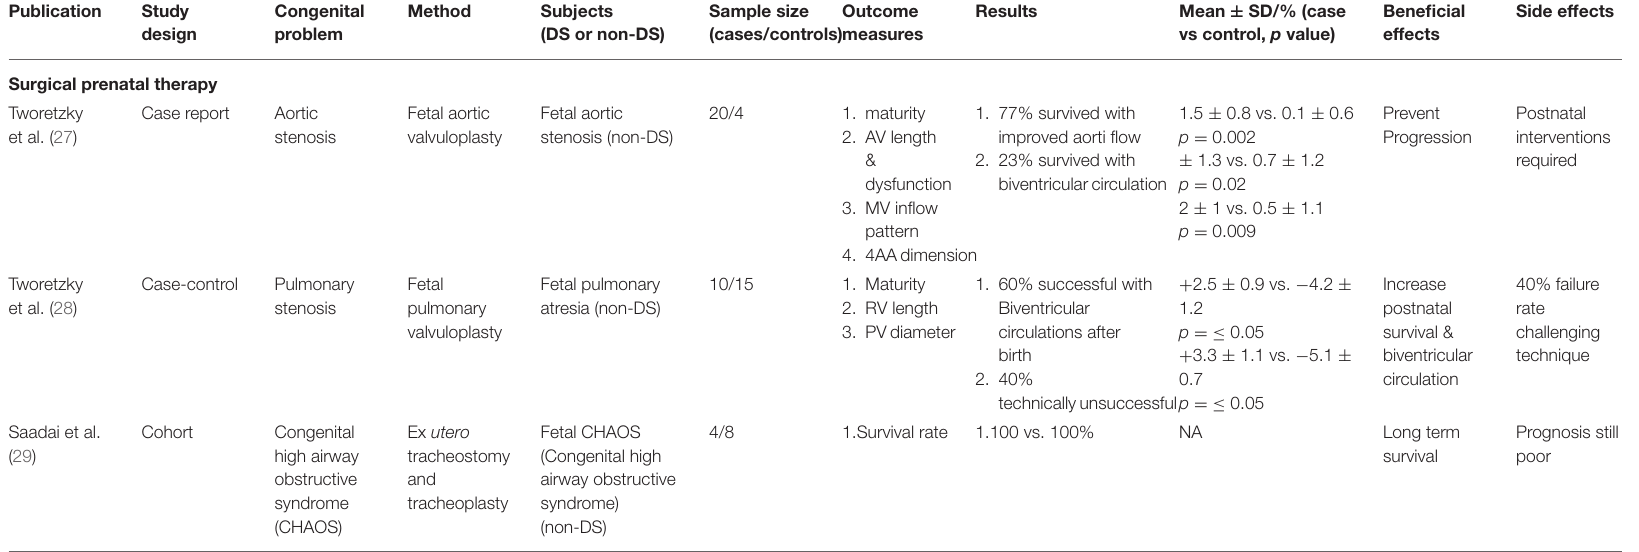
TABLE 1 | Prenatal therapy for congenital anomalies of Down’s syndrome or similar anomalies associated with Down’s